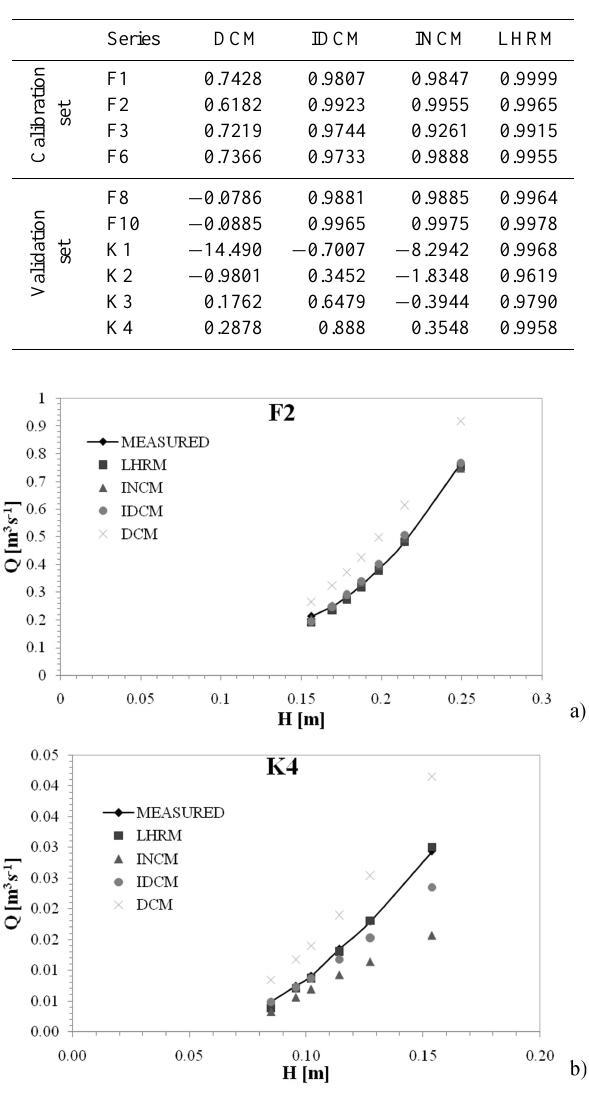
Table 3. Nash–Sutcliffe efficiency for all (calibration and valida- tion) experimental series.